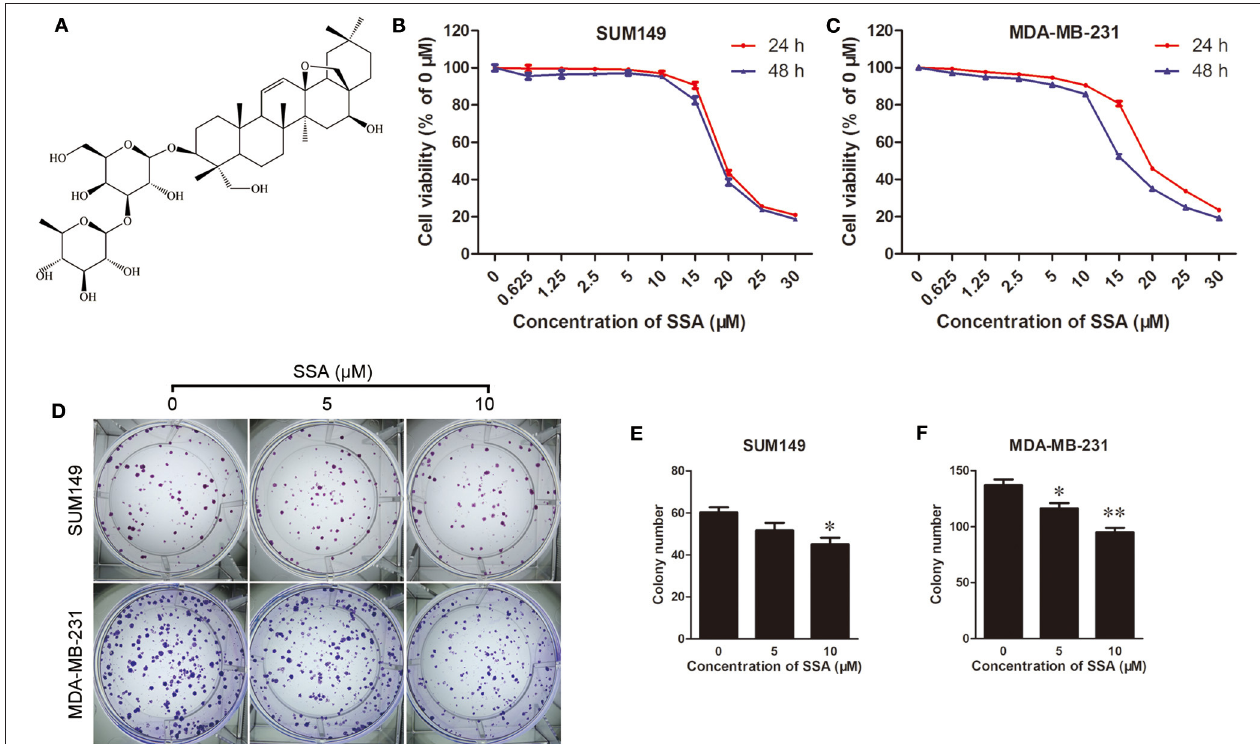
FIGURE 1 | SSA inhibits growth and colony formation of TNBC cells. (A) Chemical structure of SSA. SUM149 (B) and MDA-MB-231 (C) cells were treated with SSA at concentrations of 0, 0.625, 1.25, 2.5, 5, 10, 15, 20, 25, or 30 µ M. At 24 and 48h, cck-8 assays were performed, and cell viability was determined. Data from three independent experiments were pooled. (D) SUM149 and MDA-MB-231 cells were treated with SSA at different concentrations of 0, 5, and 10 µ M for 12 days. Colonies were stained with crystal violet. Data for SUM149 cells (E) and MDA-MB-231 cells (F) from three independent experiments were pooled. * p < 0.05; ** p <